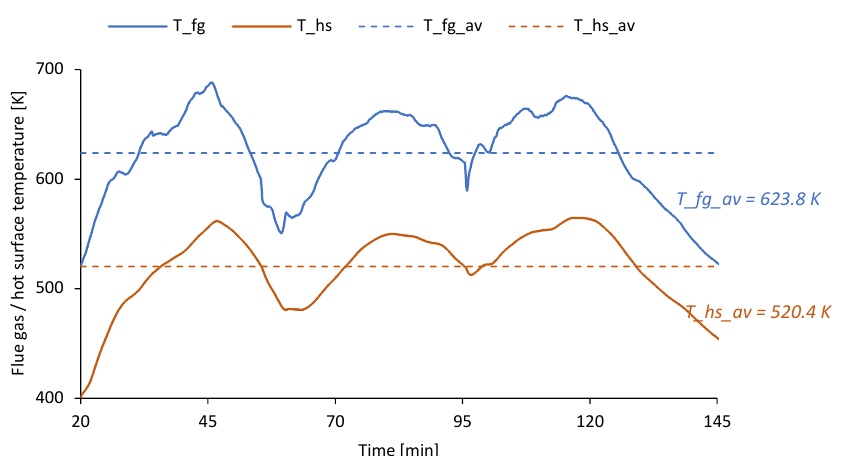
Figure 8. Variations in the temperature of the flue gas ( T_fg ) and hot surface ( T_hs ) during the main phase of the analyzed combustion process.